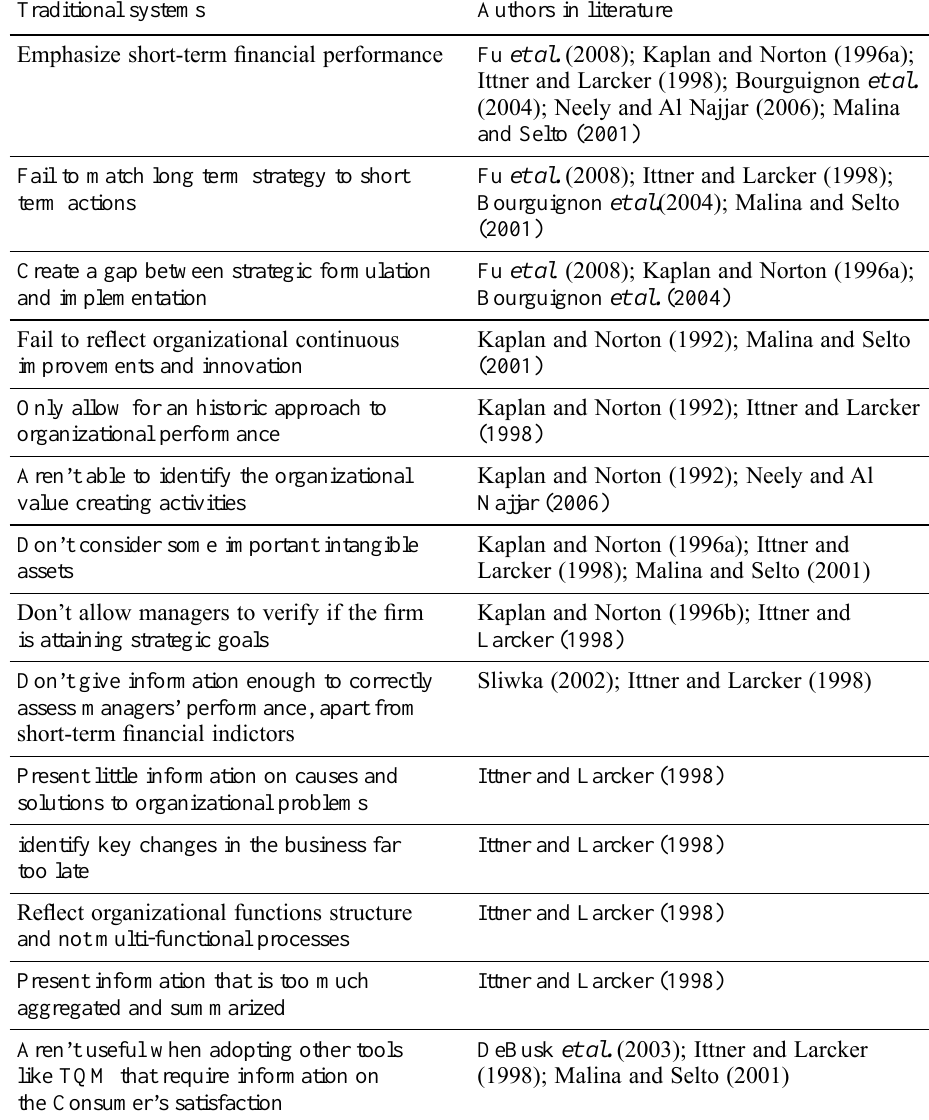
Table 1. Deficiencies in traditional